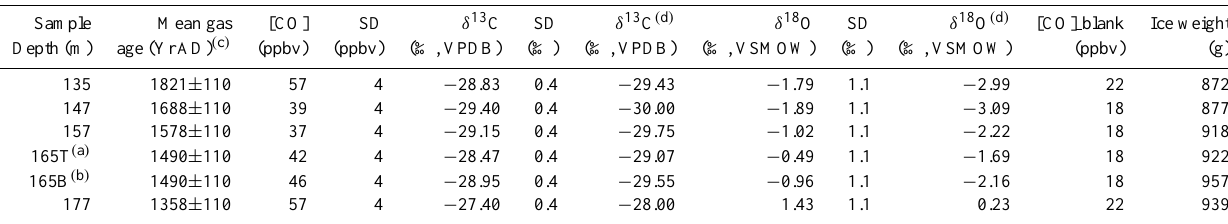
Table 5. Online extraction CF-IRMS measurements for South Pole ice core CO. Sample